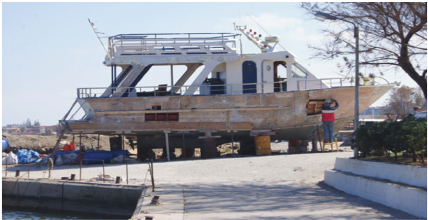
Figure 4: Boat maintenance and repainting, Platanias port, March